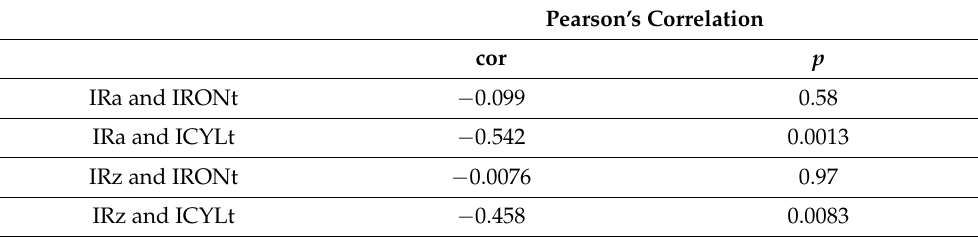
Table 6. Pearson’s product–moment correlation coefficients and p values for surface roughness improvement ratios (IR a , IR z ) and roundness parameter improvement ratios (IRONt, ICYLt). Pearson’s Correlation cor p IRa and IRONt − 0.099 0.58 IRa and ICYLt − 0.542 IRz and IRONt − 0.0076 IRz and ICYLt − 0.458